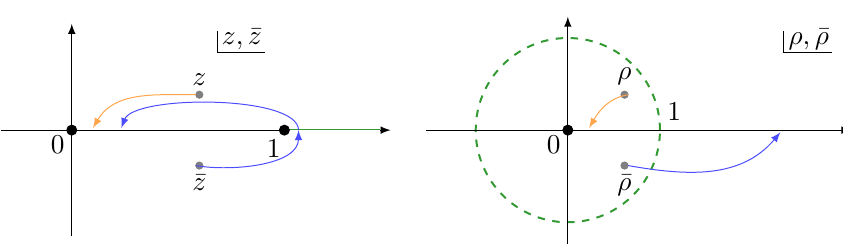
Figure 5 . The paths of ( z; (cid:22) z ) and ( (cid:26); (cid:22) (cid:26) ) under the analytic continuation to (cid:22) (cid:26) > 1 regime for the time-ordered correlator. When (cid:22) (cid:26) goes out of the dashed unit sphere in the complex (cid:26) -plane, (cid:22) z crosses the branch cut on the positive real half line [1 ; 1 ) in the complex z